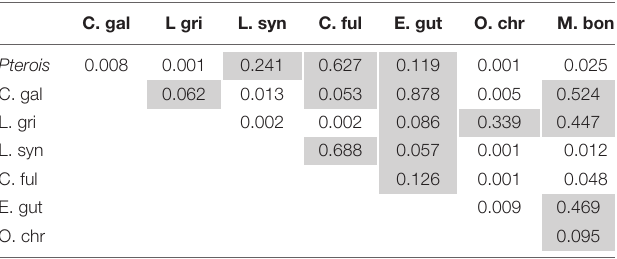
Shaded cells indicate where niche widths were not significantly different (p > 0.05).